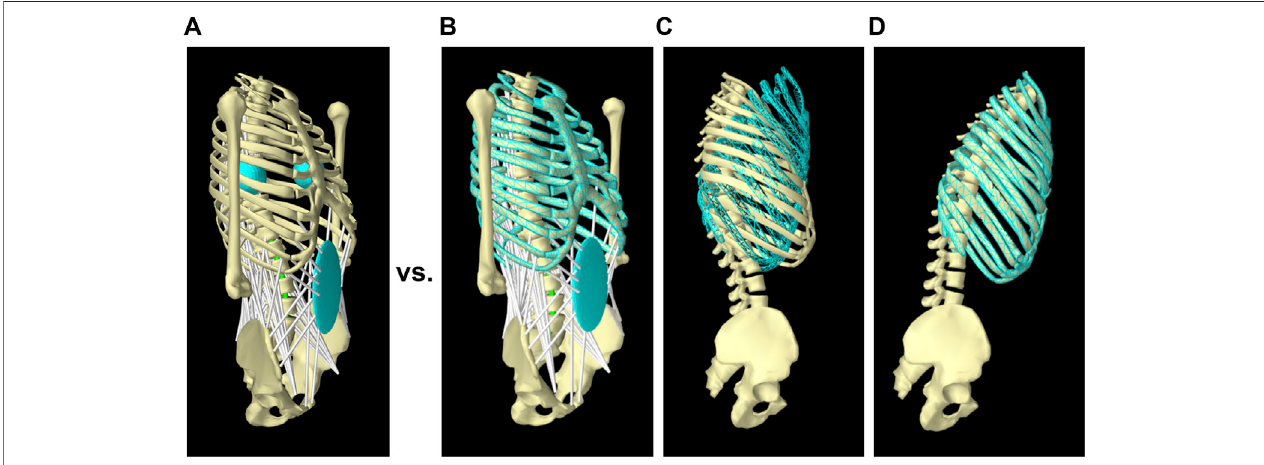
FIGURE 2 | Tracking target frames instead of target points in the new solution method. In the previous model (Malakoutian et al., 2016b), the full trajectory of two symmetric target points located at the right and left of the thorax was assigned as input and tracked by the model (A) ; while in the new solution method, only rotation of the thorax was given as input (B and C) and followed by the model (D)